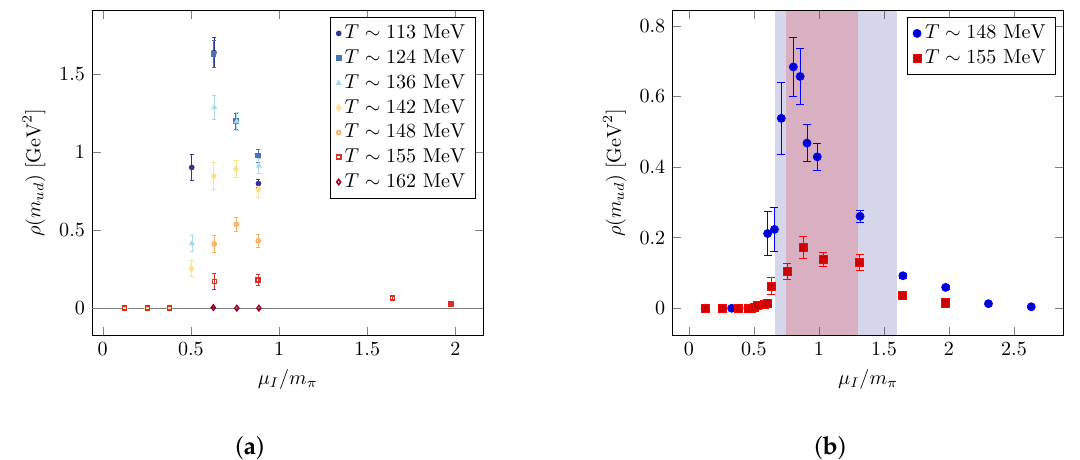
6 ( a ) and 24 3 6 ( b ) × ×